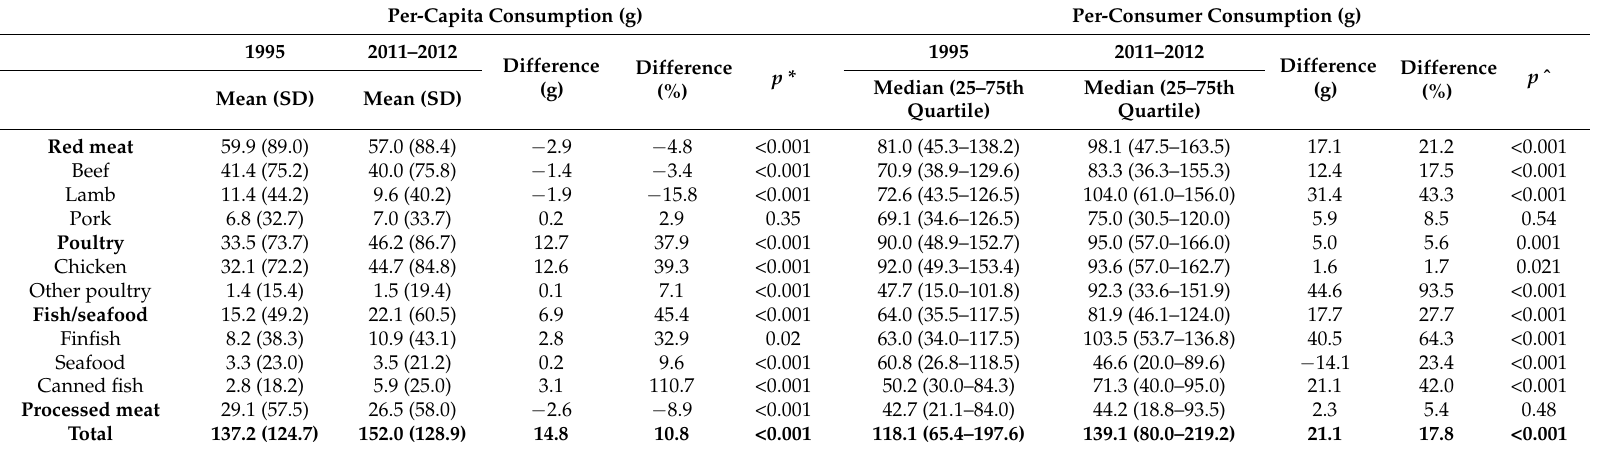
Table 2. Per-capita and per-consumer consumption (g) of meat/poultry/fish from 1995 to